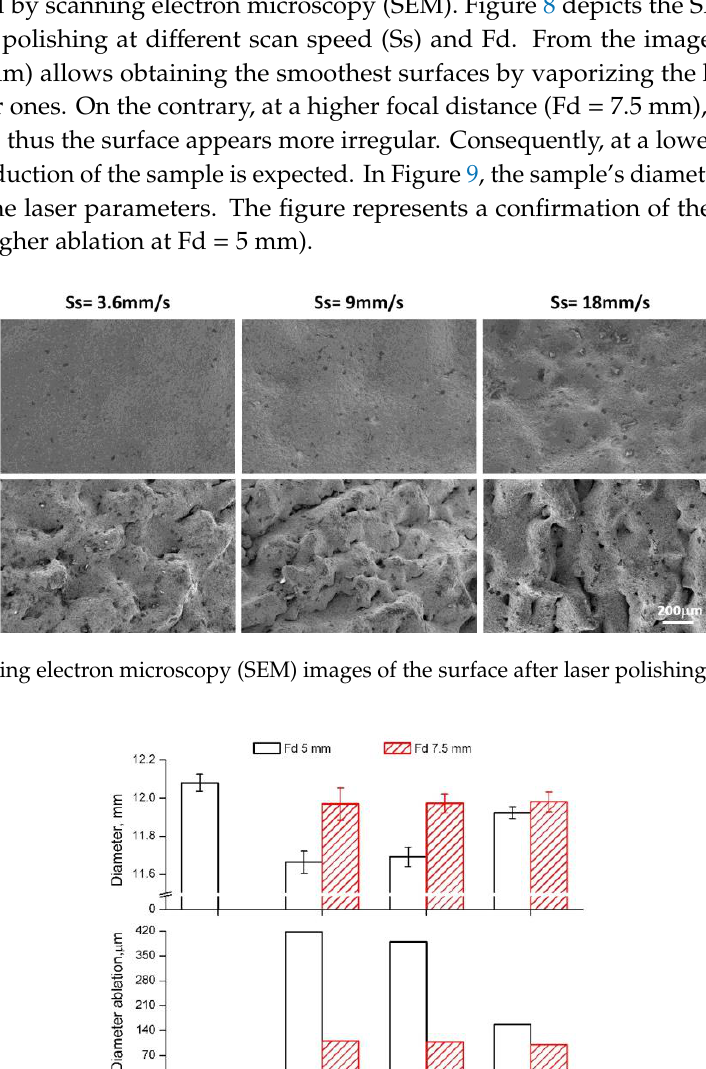
Figure 7. ( a , d , g ) Cross-sections, ( b , e , h ) their magnifications, and ( c , f , i ) surface morphologies after laser polishing at different Ss and Fd = 7.5 mm. Table 6. Circumferential overlap percentage (COP) at different scan speed and focal distance.